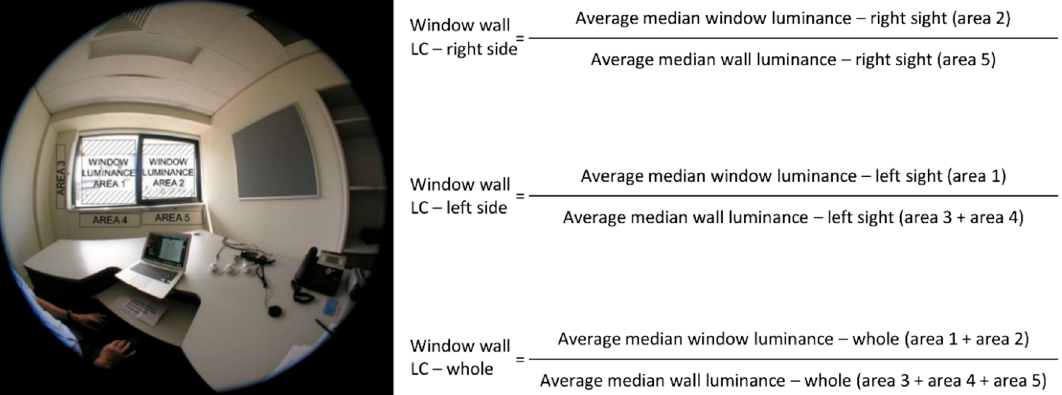
Figure 4. Captured high dynamic range (HDR) image from the test office room and window wall luminance contrast (LC) calculation